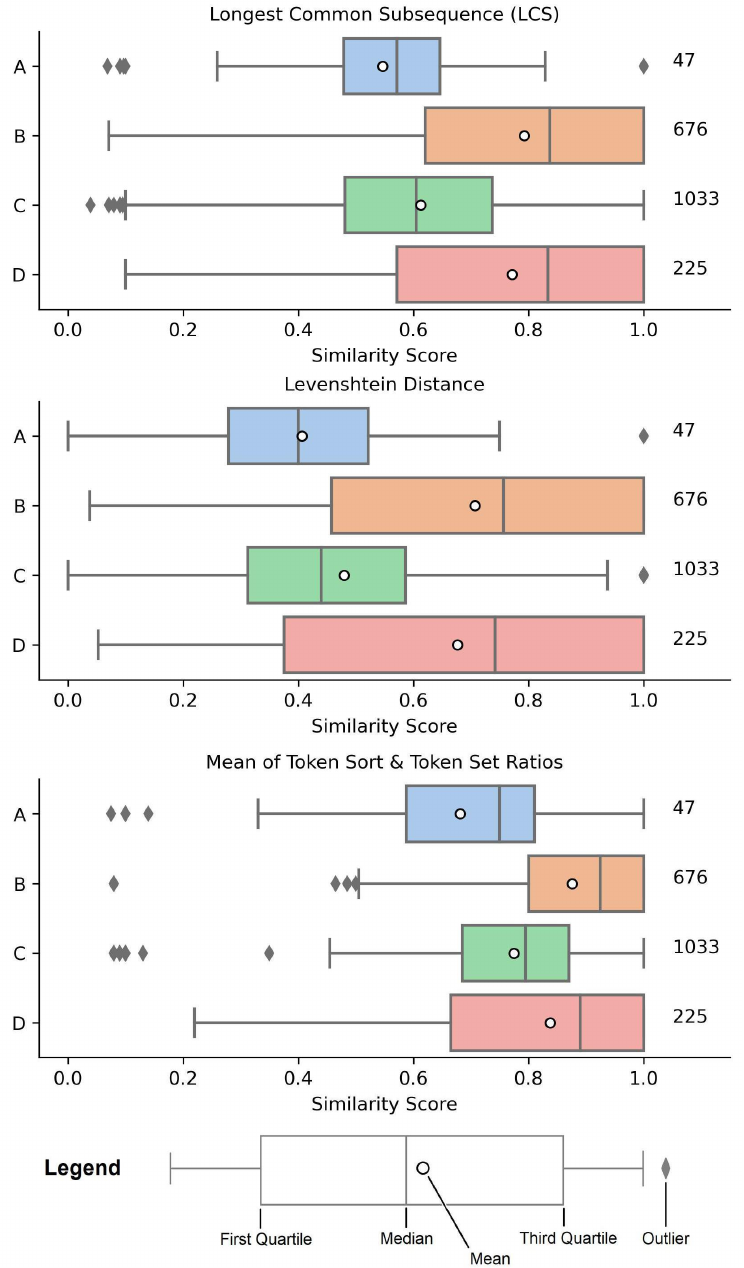
Figure 6. Distribution of string similarity scores of POI names between corresponding points in four data sources ( D eval ) and D ref . String similarity scores were calculated according to three string similarity measures. Numbers on right of the distribution indicate number of corresponding points in each data